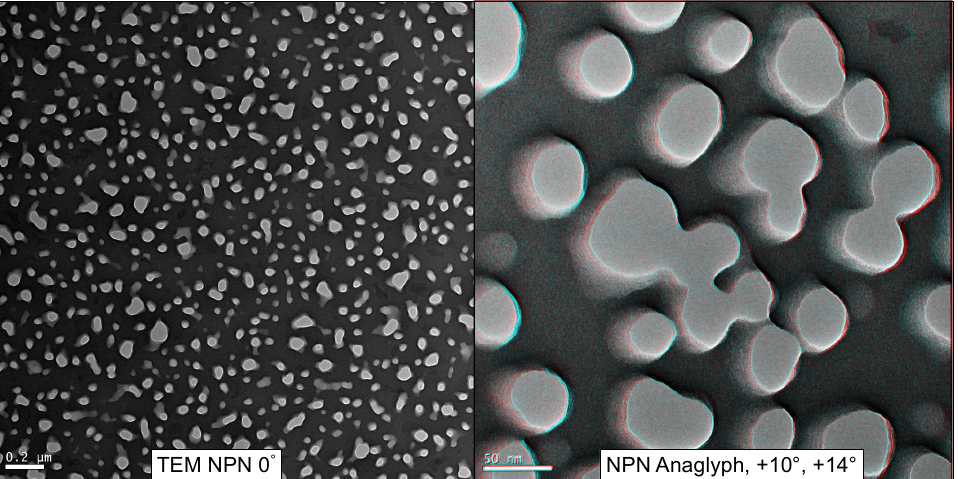
Figure 3. NPN Anaglyph. NPN (50–100 nm thick) was imaged from −14° to +14°, in 2° increments. The anaglyph was formed by taking the +10° and +14° images, aligning them using Fiji [27], and assigning them to red and cyan color channels. Viewed with red/cyan colored glasses, the anaglyph can provide the illusion of depth (best viewed on a computer screen).